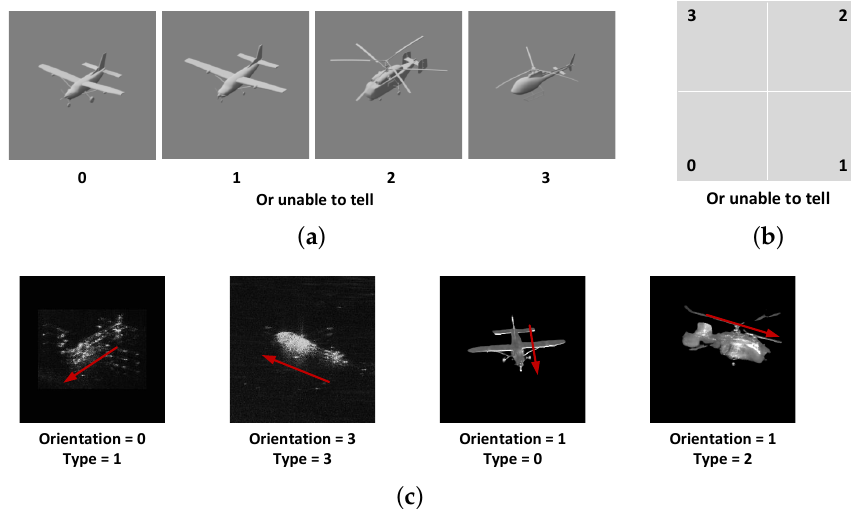
Figure A1. Details of manual target recognition experiments. ( a , b ) are the judgment criteria of types and orientations, respectively. ( c ) shows examples of recognition in SAR images and translated